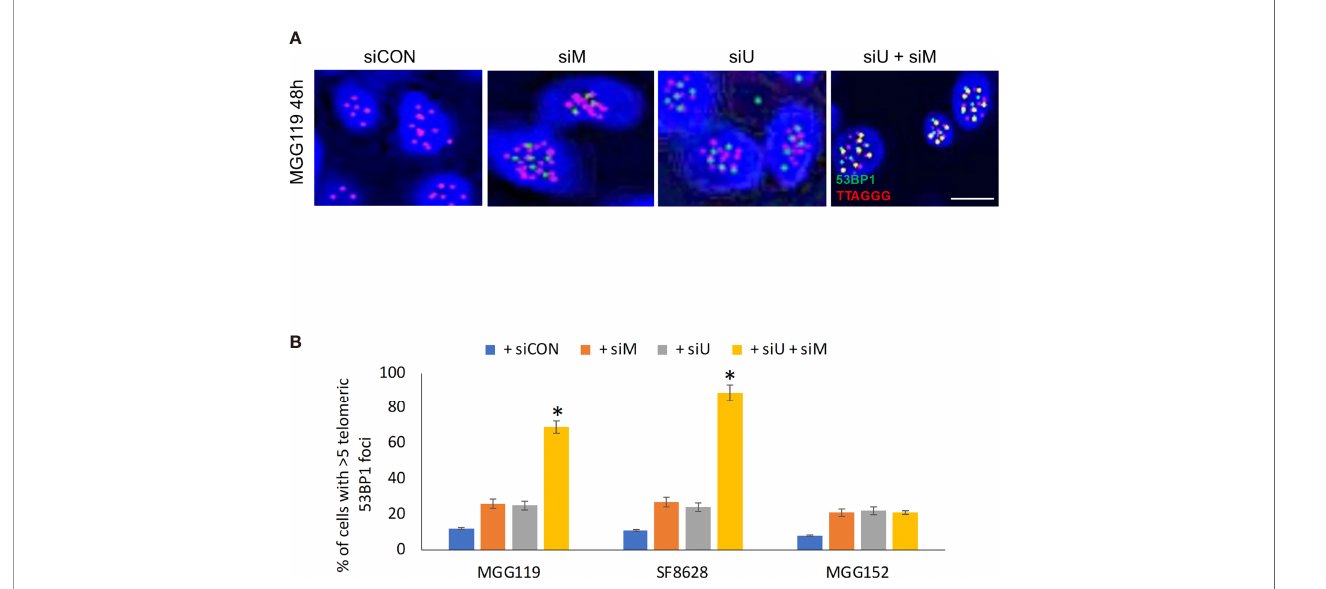
FIGURE 2 | (A) Representative images of colocalized (yellow) immuno fl uorescence from a telomeric probe (TTAGGG, red) and a 53BP1 probe (green) in DAPI- stained MGG119 cells after 48 hours exposure to scrambled siRNA control (siCON) or pooled siRNA targeting MRE11 (siM), UBR5 (siU) or both. Scale bar, 10 m m. (B) Percentage of cells with >5 telomeric 53BP1 foci. Statistical signi fi cance relative to control (siCON) is indicated. Data are the means of triplicate samples ± SD derived from groups of >100 cells. *P < 0.05.